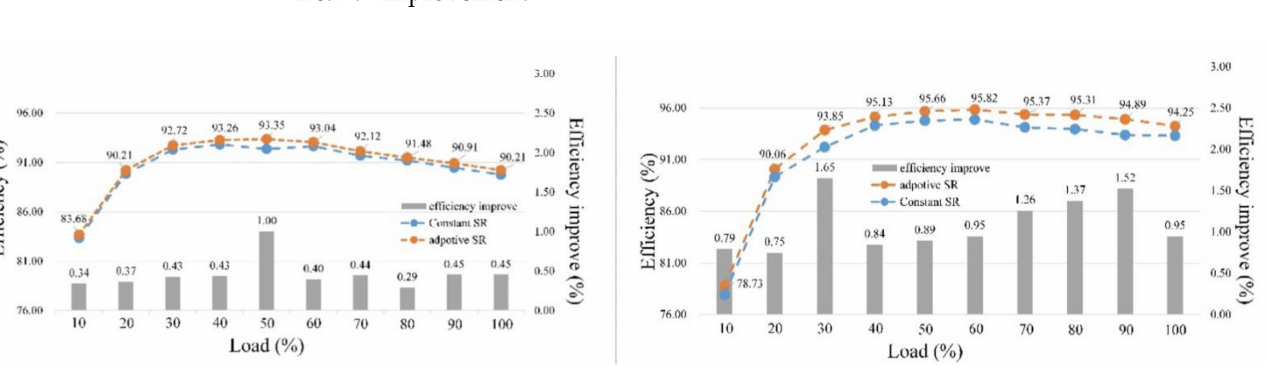
Figure 21. Efficiency